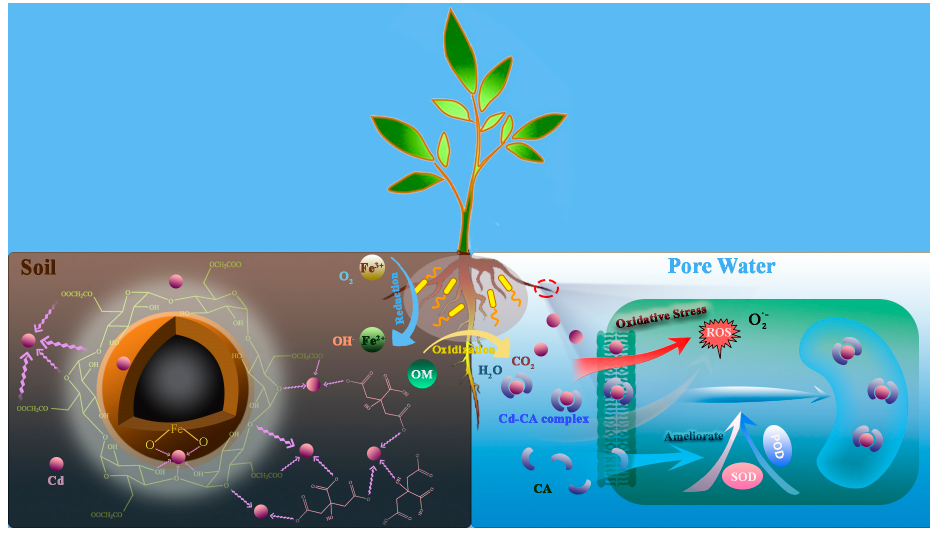
Figure 10. Proposed inner mechanisms for the nanomaterials’ remediation of Cd-polluted soil in the presence of root exudates and microflora.